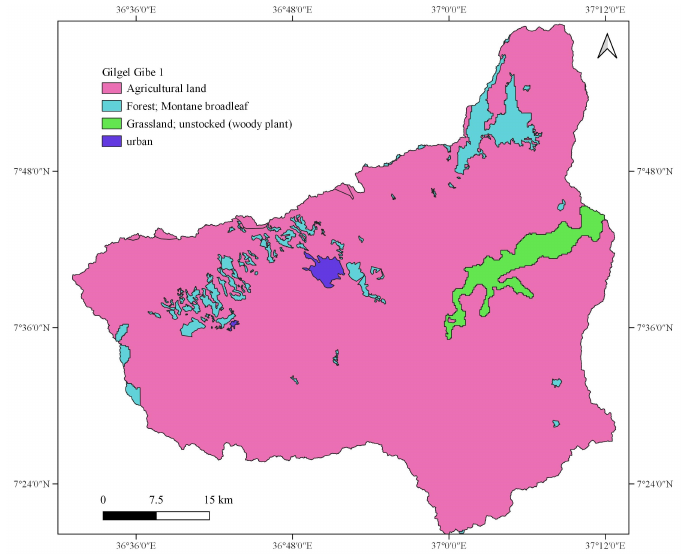
Figure A11. Land use map of Gilgel Gibe 1 Watershed from 2010 to